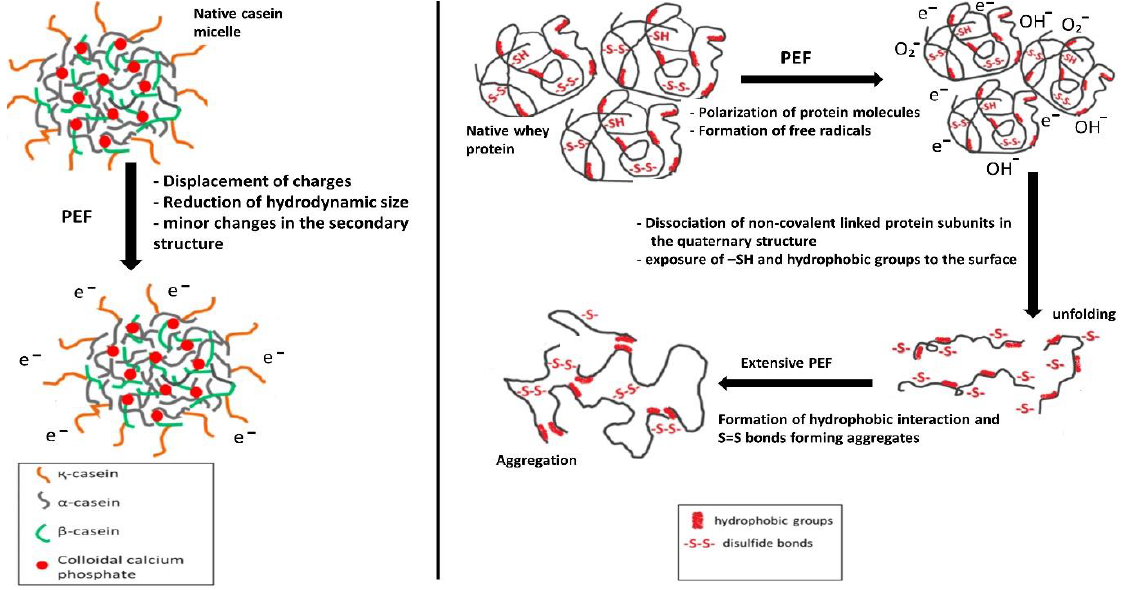
Figure 6. Mechanism of PEF effects on the structural properties of milk proteins (caseins and whey proteins); adapted with permission (License number: 5001830472118) from [4]. Copyright (2019) Elsevier.